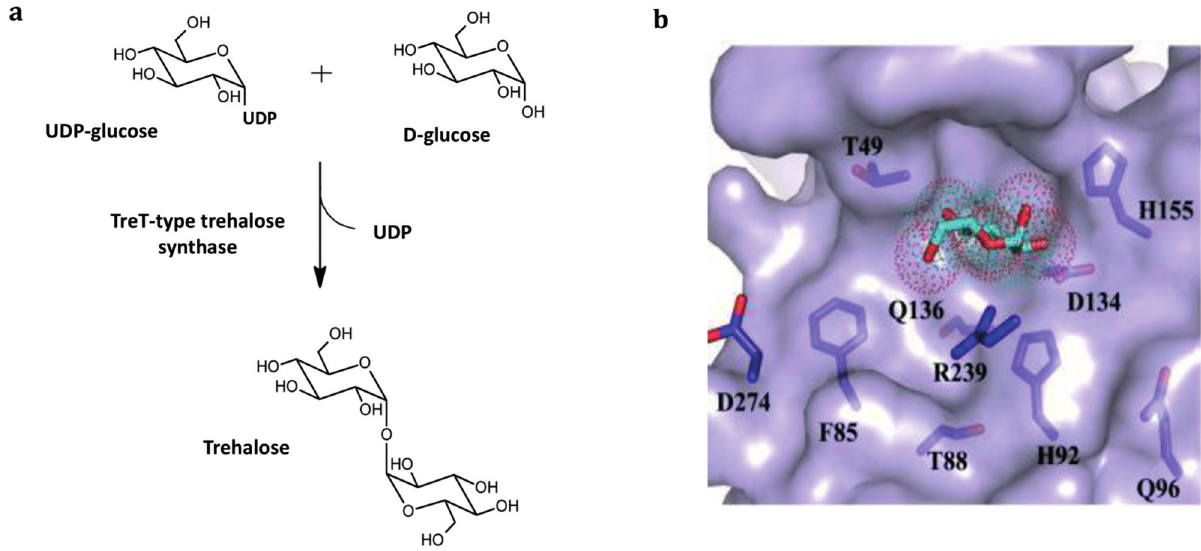
Figure 5. TreT-type trehalose synthase. ( a ) Natural reaction in trehalose synthesis direction starting from UDP-glucose and D -glucose; ( b ) active site residues (indicated in dark purple) surrounding the D -glucose moiety (light blue) in the acceptor binding pocket of P. horikoshii TreT [49]. Replacing the histidine at position 92 into an alanine via site-specific mutagenesis resulted in a 10% improvement of the activity on mannose as alternative acceptor